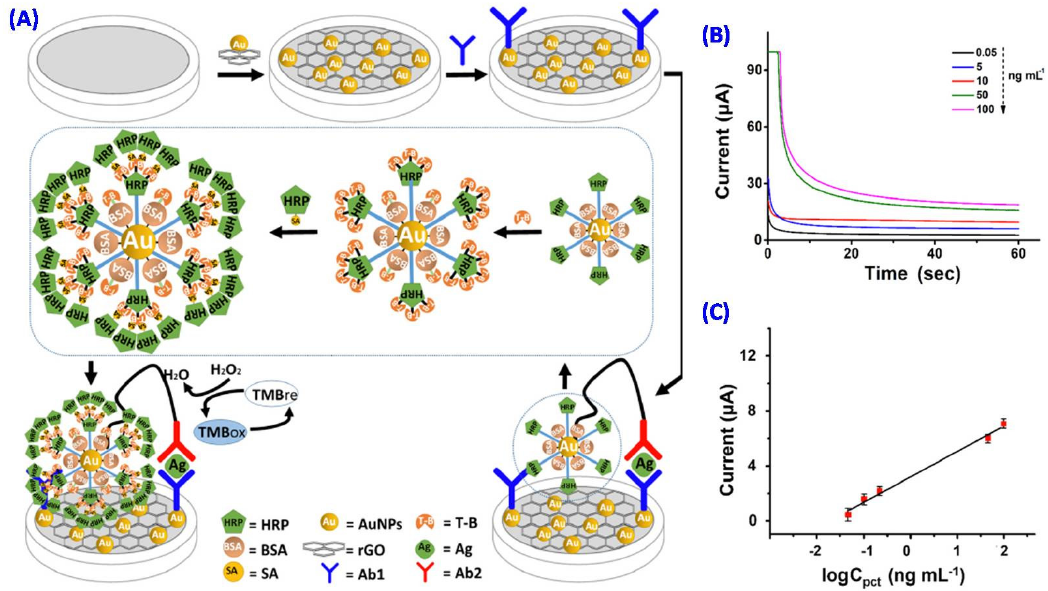
Figure 4. ( A ) Schematic depiction of the step-wise preparation of the PCT immunosensor; ( B ) Amperometric profiles of the immunosensor in different concentrations between 0.05 and100 ng/mL of PCT recorded in 0.01 M PBS of pH 7.6 containing 0.5% bovine serum albumin. ( C ) The calibration plot obtained for the immunosensor [26].